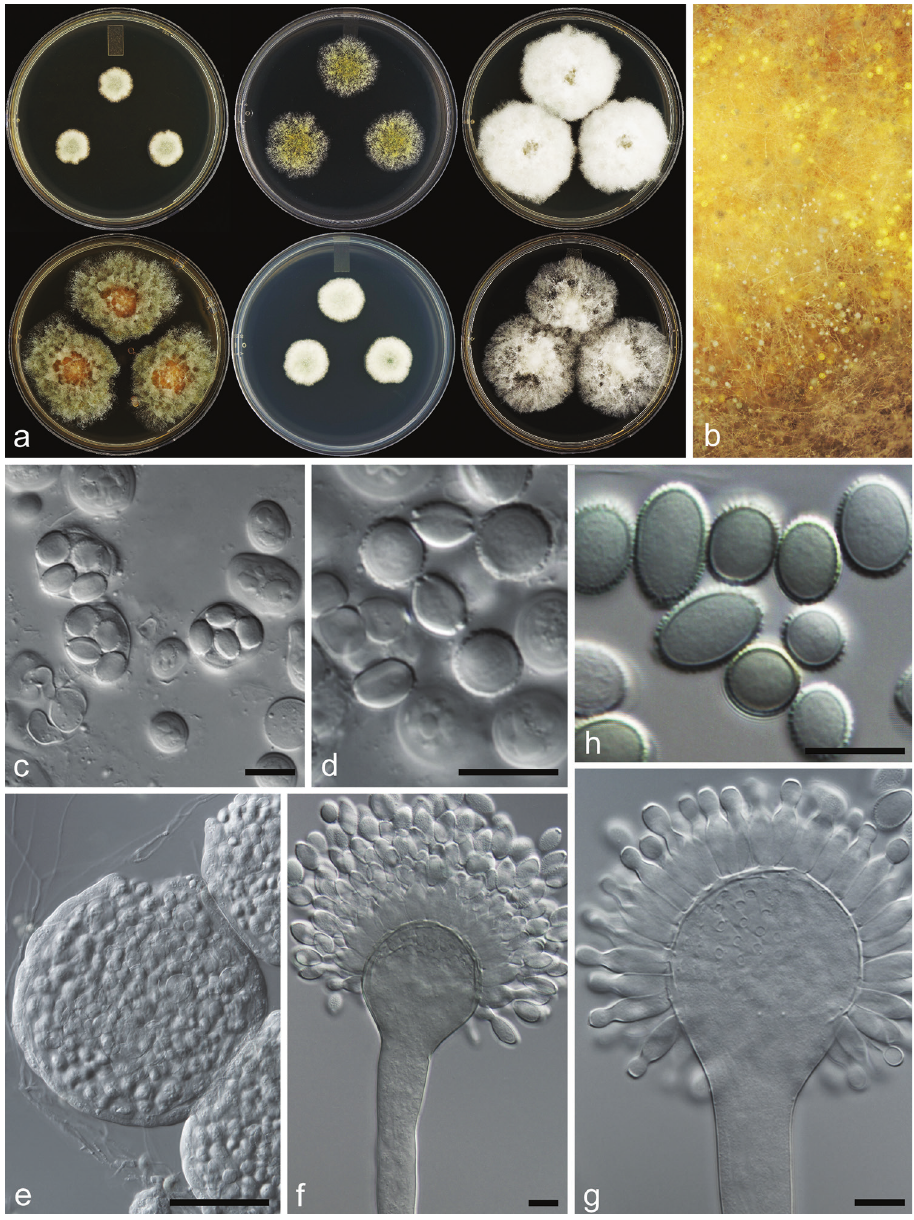
Figure 6. Aspergillus megasporus (DAOMC 250799). a Colonies on MEA, MEA20S, MY10-12 (top row, from left to right), DG18, CY20S, MY50G (bottom row, from left to right) b Texture on DG18 c Asci d Ascospores e Cleistothecium f, g Conidiophores h Conidia. Scale bars: e = 50 µm, c, d, f–h = 10